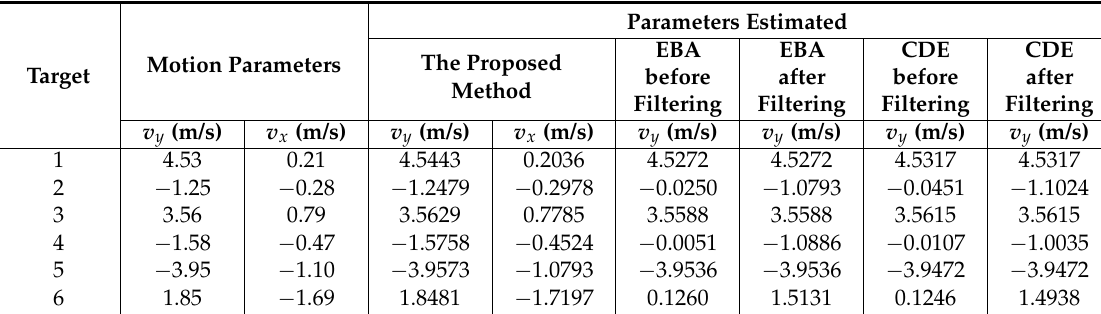
Table 1. Six Moving Targets and Their Motion Estimation.